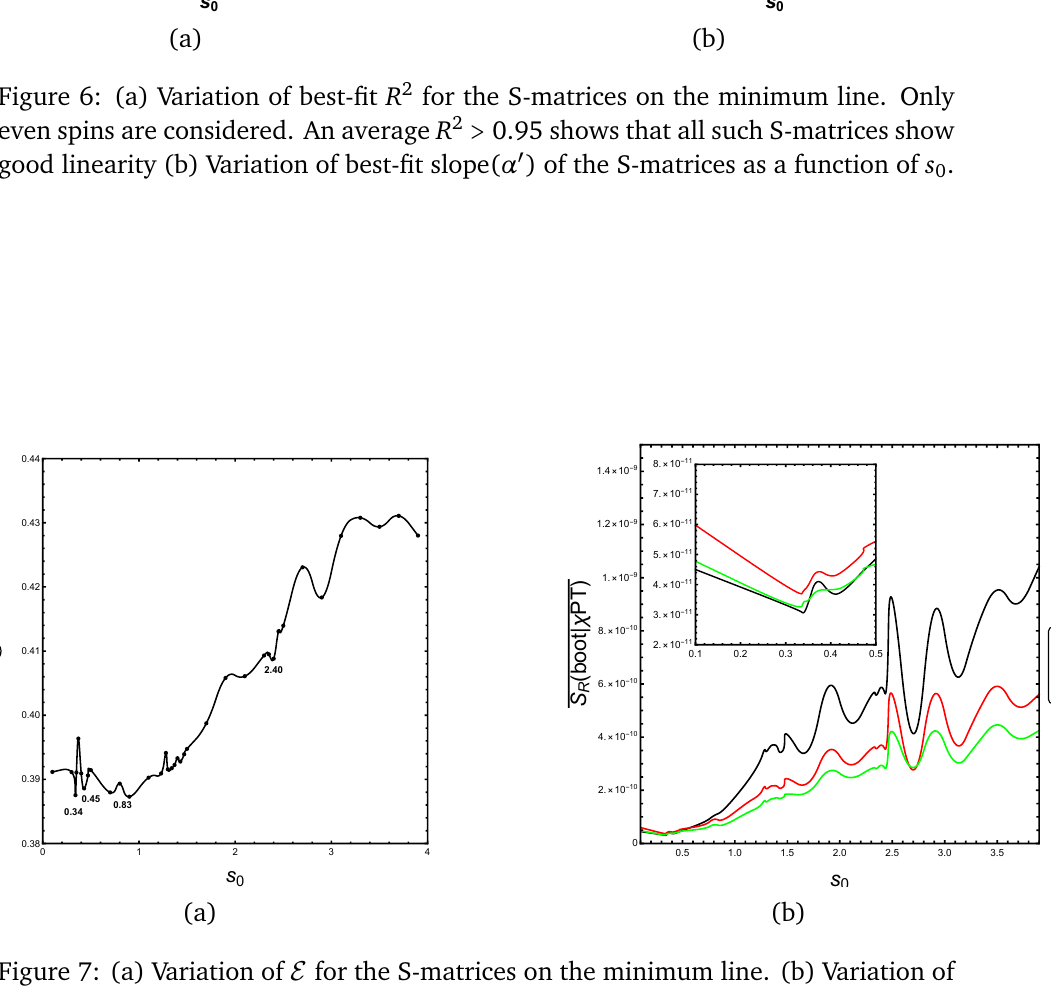
Figure 7: (a) Variation of E for the S-matrices on the minimum line. (b) Variation of averaged Relative Entropy ( S R ( ρ 1 ∣ ρ 2 ) ) of the S-matrices as a function of s 0 . A global minimum is obtained near region